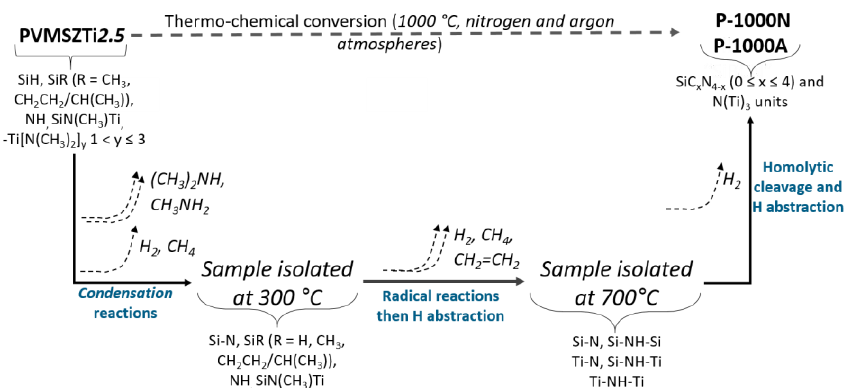
Figure 11. Schematic diagram of the thermo-chemical conversion of titanium-modified poly(vinylmethyl- co -methyl)silazanes into Si-Ti-C-N ceramics in flowing nitrogen and argon.